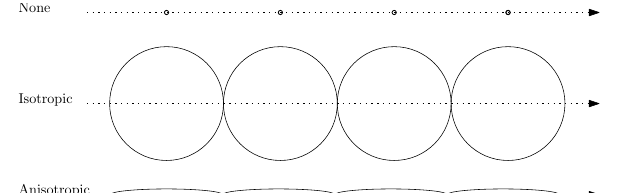
Figure 2: Prefiltering options for subsampling 1D integrals only a linear reduction on the number of texture